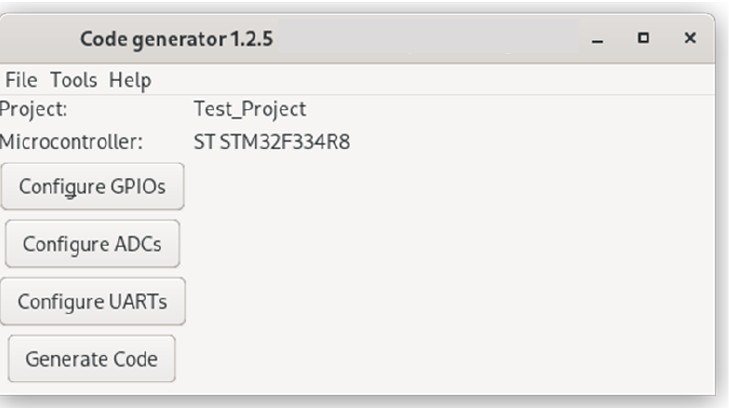
Figure 7. Code generator’s user interface main